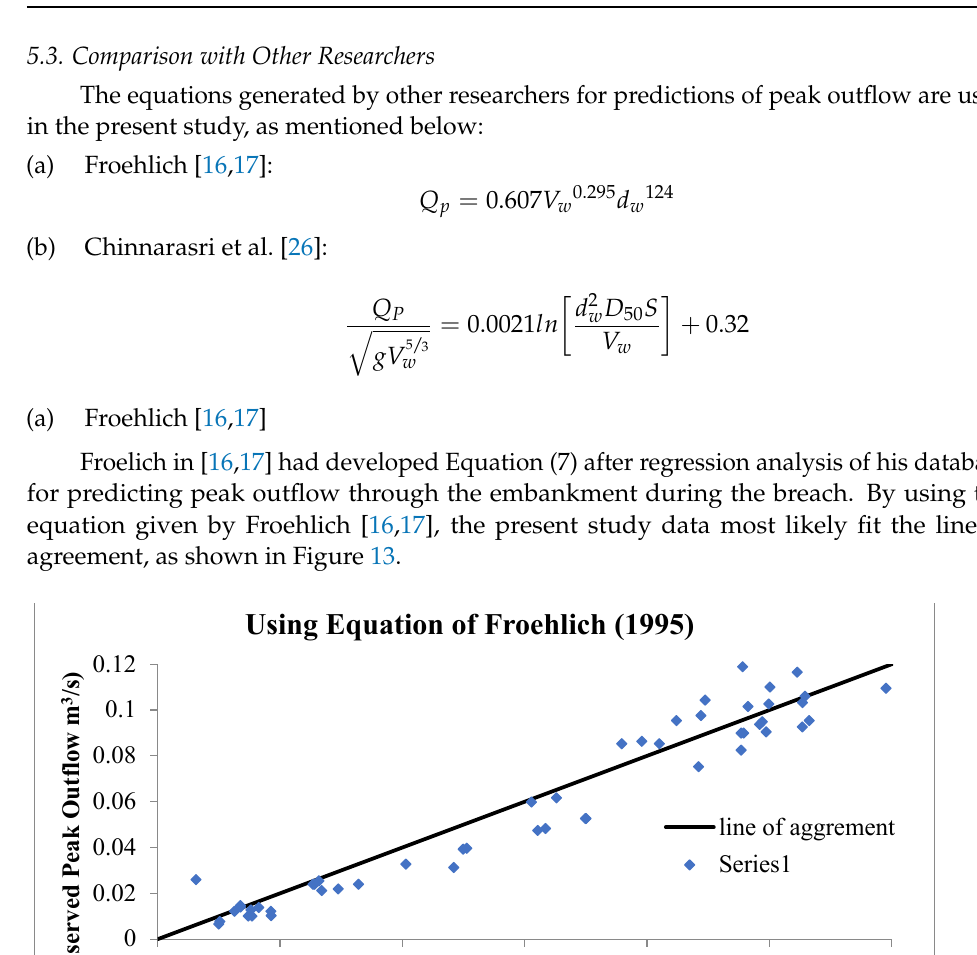
Figure 14. Variation of observed peak out fl ow with predicted peak out fl ow using Chinnarsari et al. [26] Equation (8).